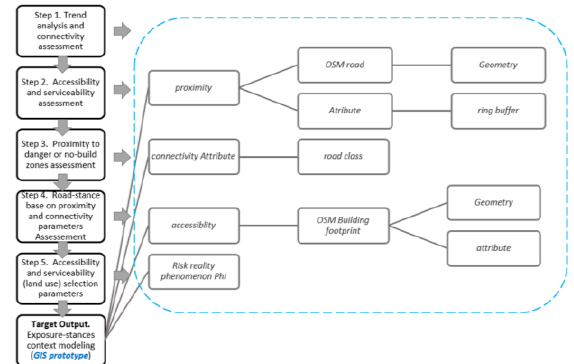
Figure 2 . GIS Modeling Approach and ES Contextualization